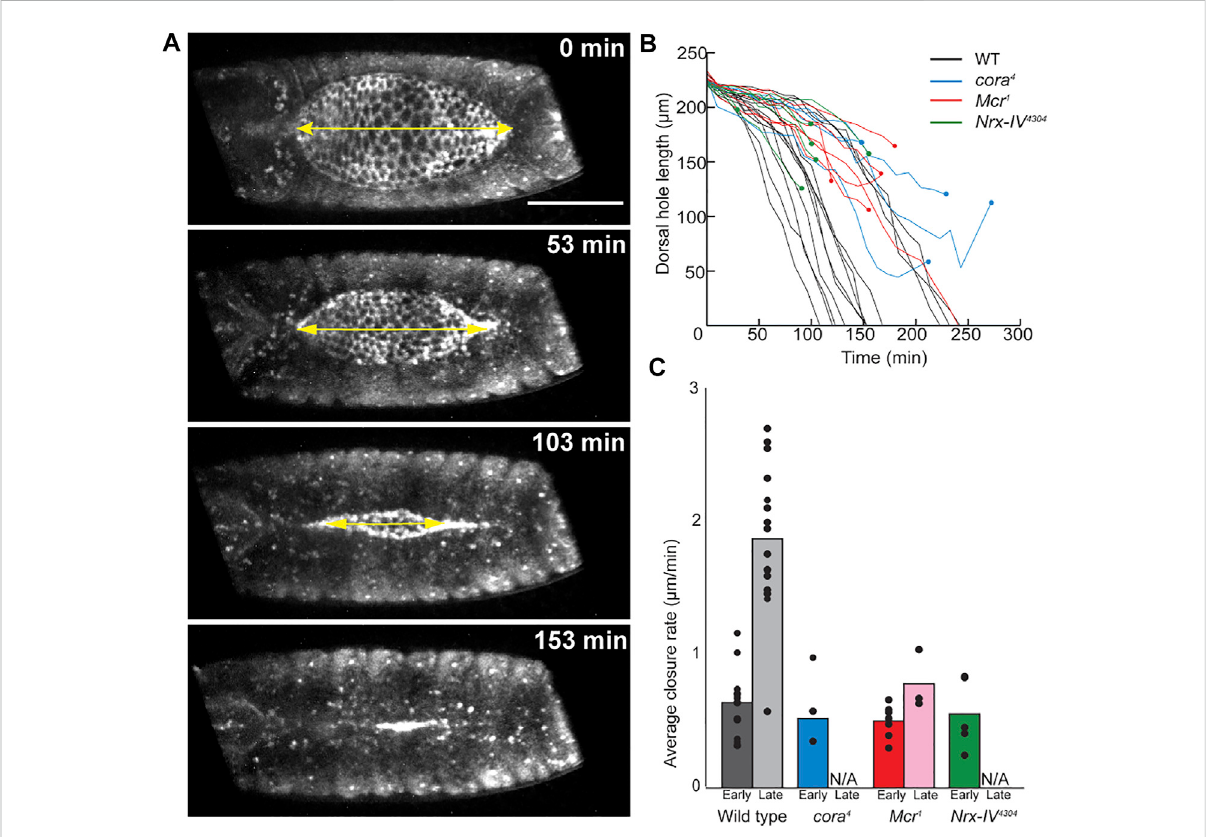
FIGURE 1 Liveimageanalysisof DC inwild typeand SJ mutantembryos. (A) Exampleof still images from time lapseseries of wildtypeembryo, showing a line segment (yellow double headed arrow) used to measure the length across the anterior-posterior axis of the dorsal hole. (B) Change in length of dorsal hole over time. Circles represent timepoints when tearing occurred. (C) Average rate of dorsal hole shortening during early (length > 190 μ m) and late (length < 190 μ m) closure. Only late closure data from embryos that closed without puckering is included. Scale bar = 100